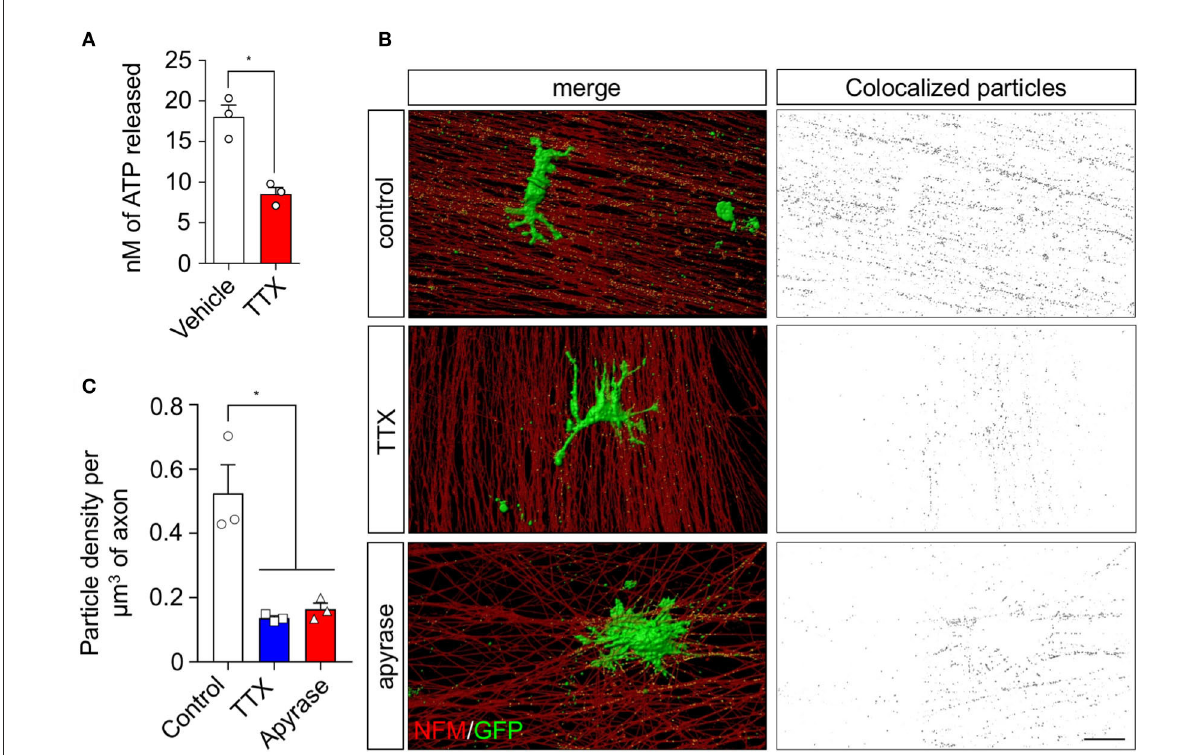
FIGURE1 sEV transfer from rSC to axons in co-culture is inhibited upon ATP depletion and action potential inhibition. The involvement of neuronal ATP and spontaneous activity in the transfer of EVs from rSC to axons was analyzed in a co-culture system. (A) DRG neurons from primary culture were seeded in white bottom culture plates and left to grow for 7 days; ATP release from neurons was analyzed by luminescence with the ATPlite detection kit in a luminescence spectrometer. (B) DRG neurons co-cultured with rSC expressing CD63-GFP to visualize EVs were analyzed for EV transfer by immunofluorescence and detection of GFP signal in axons. Scale bar, 20 µ m. (C) Colocalized particles were quantified as described in Supplementary Figure 1 and plotted as particle density per volume of axons. In all quantifications, the average and SEM values of at least three independent experiments are shown (* p <